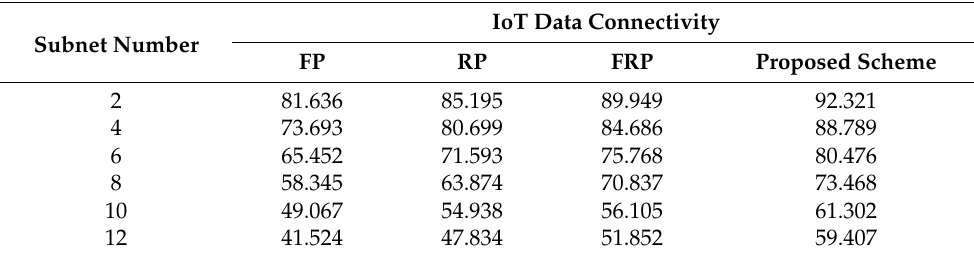
Figure 10. Overhead of IoT integrity validation by number of subnet gateway servers. Table 7. Evaluating IoT connectivity to validate IoT integrity based on subnet number. Units: